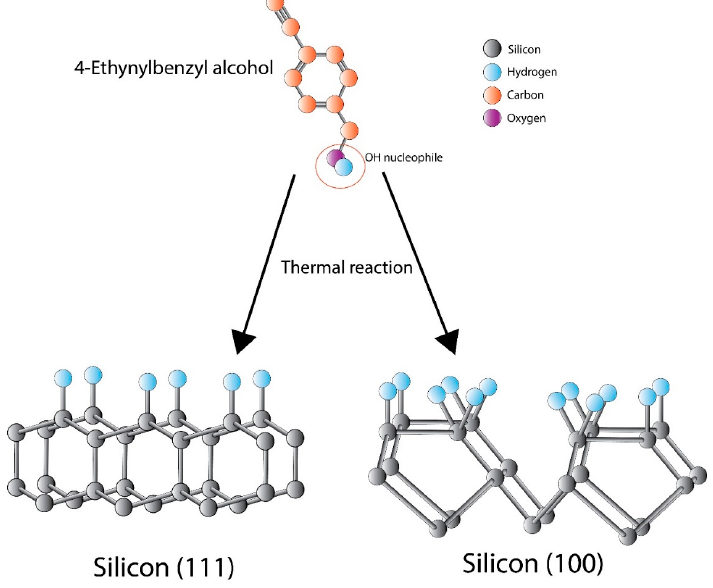
Figure 1. Illustration of the alcohol reaction to silicon hydrogenated (Si–H) surfaces of different crystal orientations.